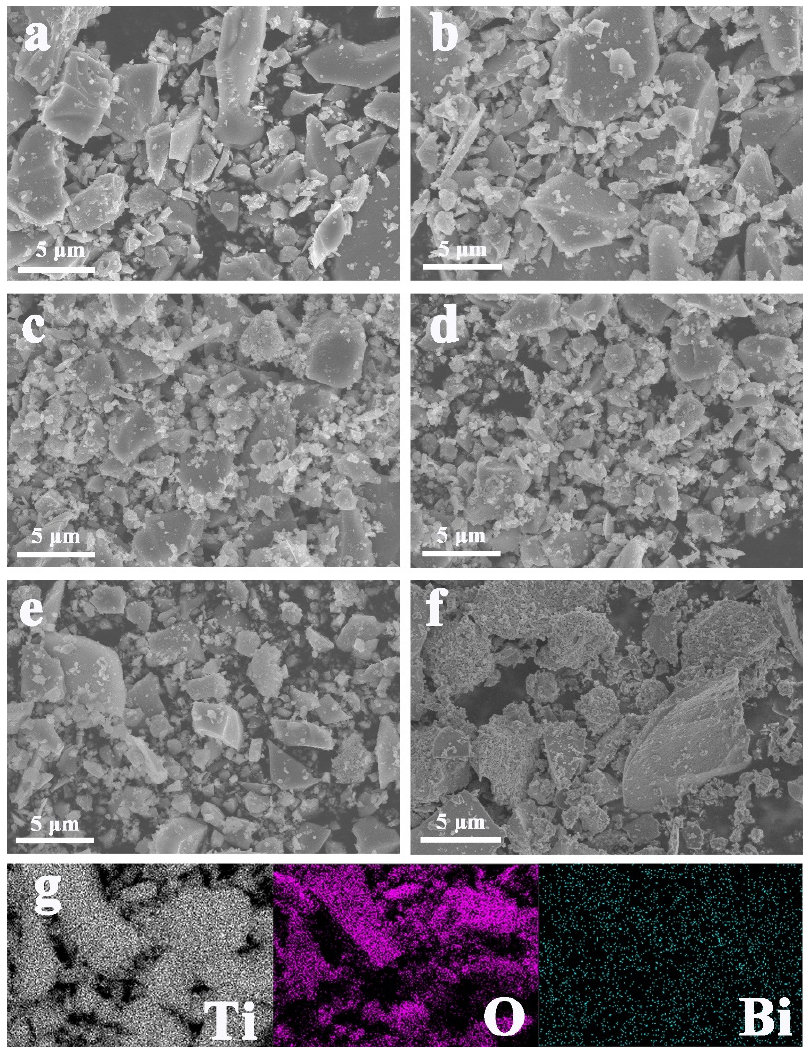
Figure 1. SEM images of ( a ) pure TiO 2 , ( b ) BT-1, ( c ) BT-2, ( d ) BT-3, ( e ) BT-4, ( f ) BT-5; ( g ) Elemental mapping images of BT-3.